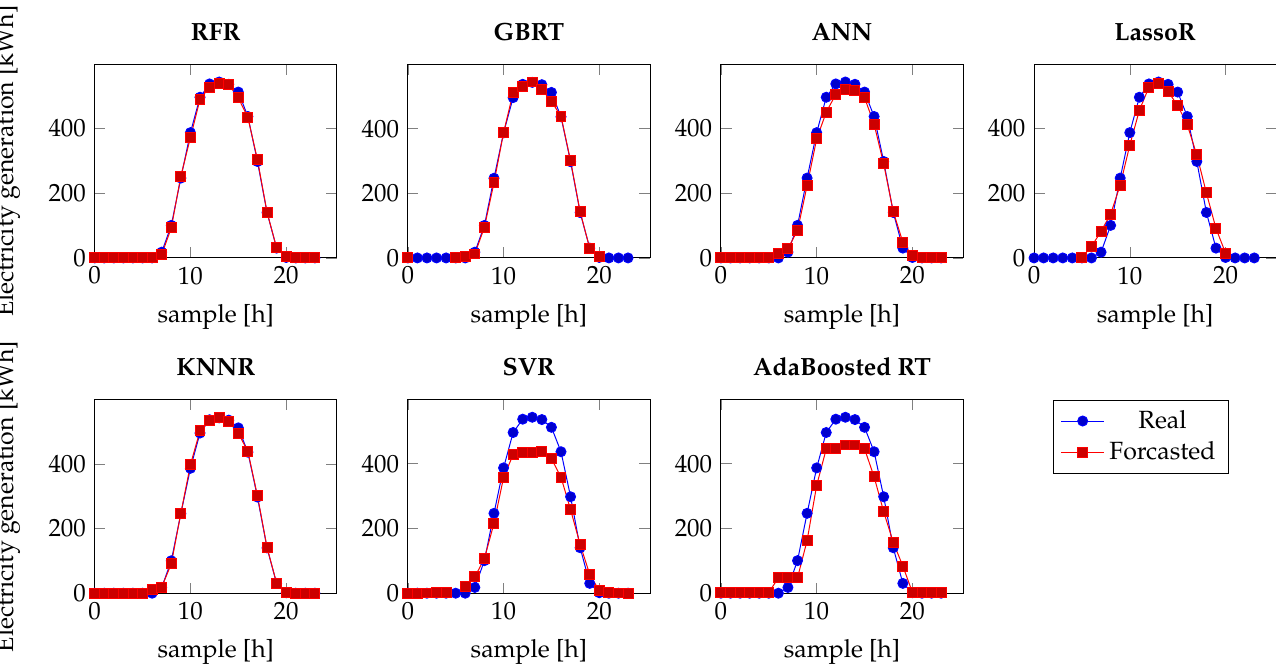
Figure 3. Forecasting results for a chosen day in which high compliance was achieved.